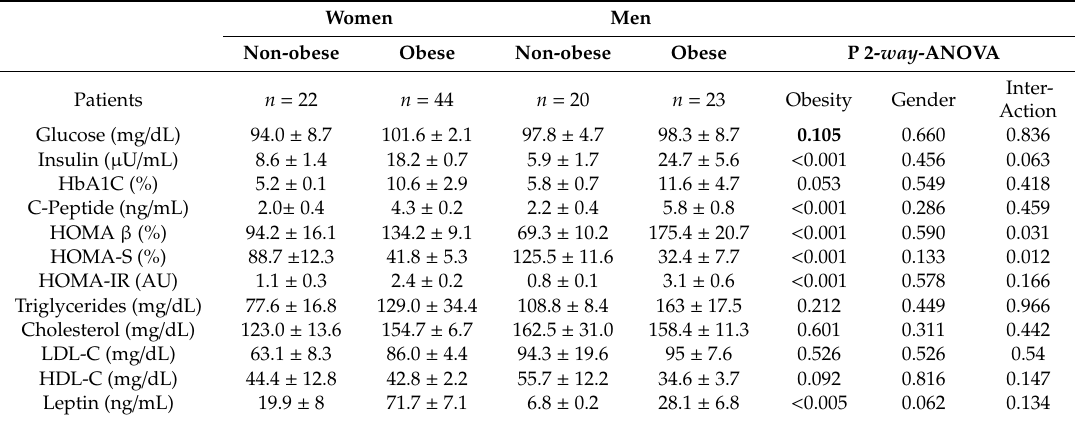
Table 2. Clinical and biochemical features of the non-obese and obese patients included in this study. Women Men Obese Obese Patients